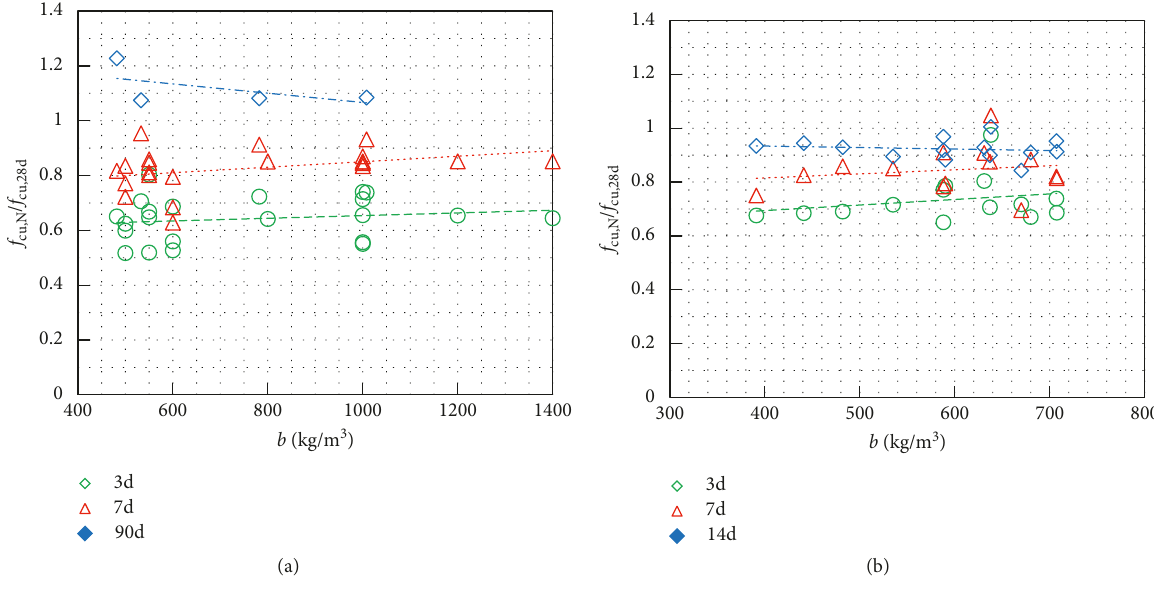
Figure 13: Effect of (m) S /(b) on (f) cu,N /(f) cu,28d . (a) f cu,N /f cu,28d versus mS/b [28] and (b) f cu,N / f cu,28d versus m S / b (this